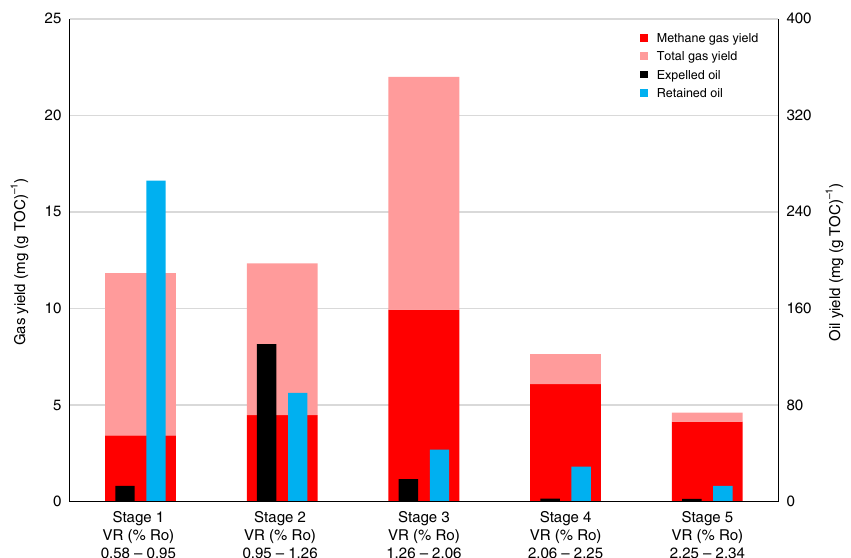
Fig. 2 Total hydrocarbon gas (C 1 – C 5 ), methane, expelled oil and retained oil/bitumen yields (mg/g TOC of the rock at the end of each stage) for the HPWP experiment on Rempstone shale at 300 bar. The VR % (Ro) values below each histogram are for the start and end of each stage. The differences in the measured values from duplicate tests are generally within 6% for gas (C 1 – C 5 hydrocarbons) yields, 4% for expelled and retained oil yields and 2% for gas dryness